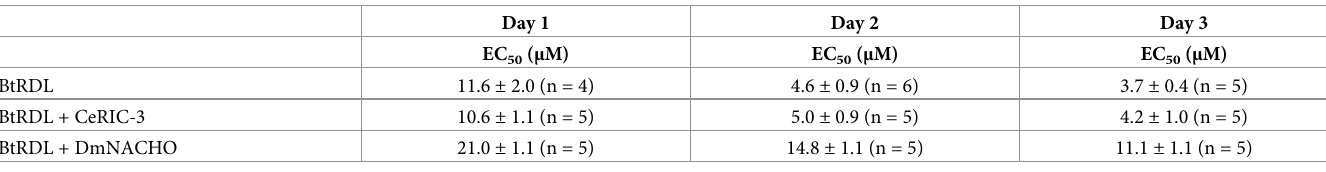
Table 2. Influence on co-expressed chaperones on GABA apparent affinity (EC 50